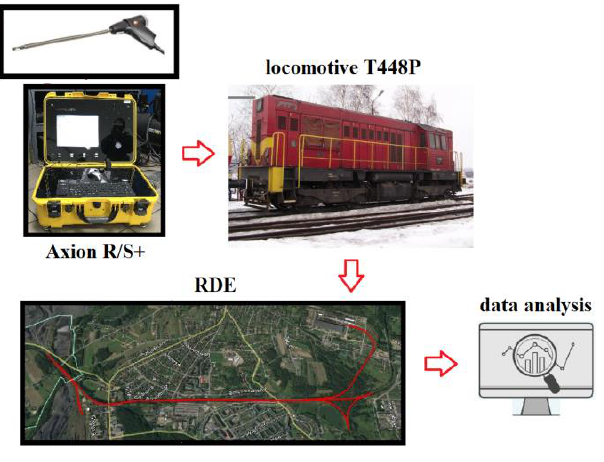
Fig. 8. Diagram of the performed tests